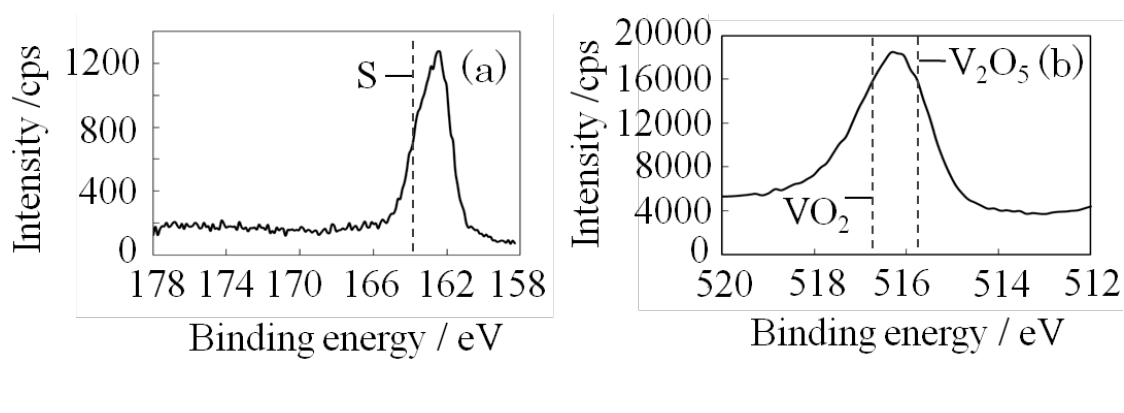
O : ( a ) S2p; and 2 5